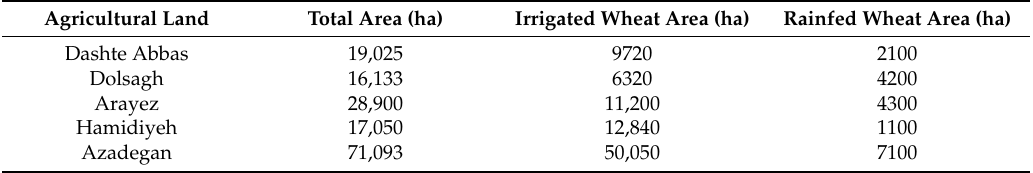
Table 2. Distribution of wheat and maize in five major agricultural lands in Lower Karkheh reported by Iran Water and Power Resources Development Co.